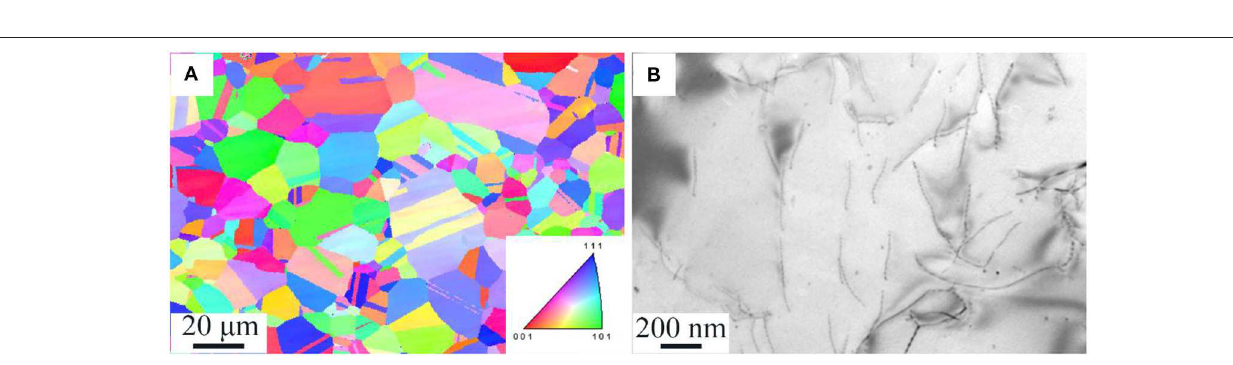
maintaining a good ductility. The uniform elongation was